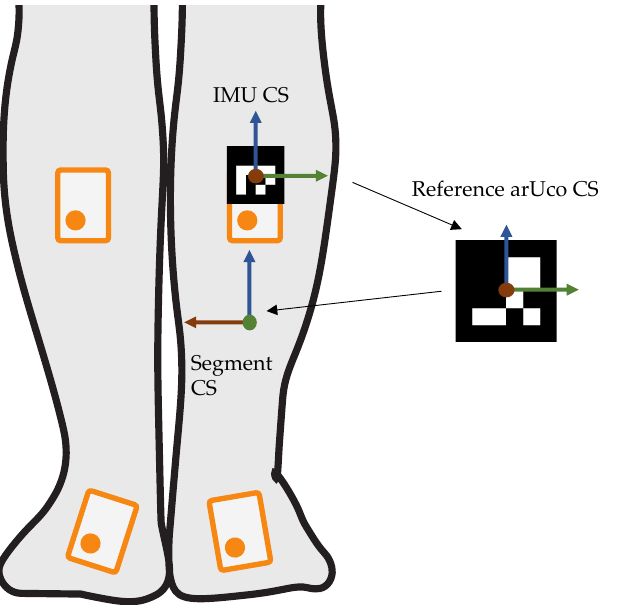
Figure 3. Derivation of the transformation between the IMU CS and the body segment CS. The CS consist of x- ( red ), y- ( green ) and z-axis ( blue